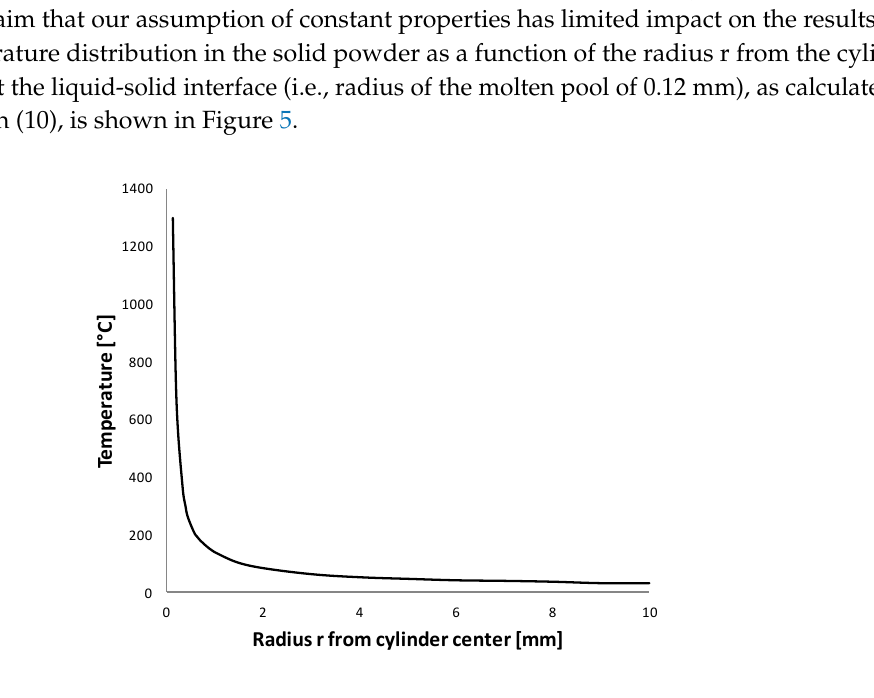
Figure 5. Temperature distribution as a function of radius r from the cylinder center with a melt pool radius of 0.12 mm at time 𝑡 = 𝜏 . The power per unit length is set to 𝑄 ′ ̇ = 10000 W/m .